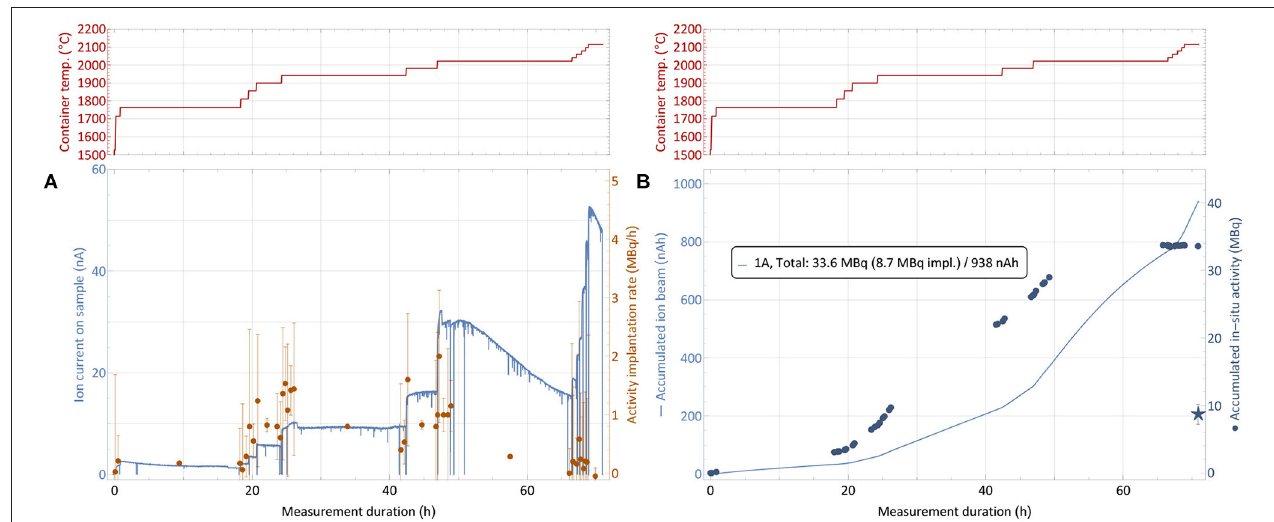
FIGURE 6 | 167 Tm collection process for sample 1 (82.5MBq 167 Tm, see Table 1 ). The top panels show the sample container temperature over time. The bottom left graph (A) depicts the ion current measured on the implantation foil and the rate of 167 Tm activity implantation. The bottom right graph (B) depicts the respective accumulated values. Due to sputtering effects of the high intensity ion beam, only a fraction of the activity measured to be present in the collection chamber remained on the foils, as shown by the star marker that depicts the gamma-ray spectroscopy measurements of the foils after collection. Errors on the activity are 95% confidence intervals of constant 0.2MBq for the activity which are propagated into the rates. The inset in (B) describes the measured total in-situ activity in comparison to the gamma-ray spectrometry of the foil afterwards and the integrated intake of ion